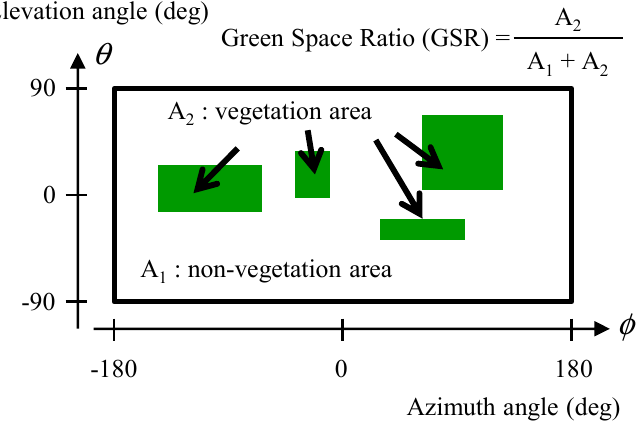
Figure 3. Occlusion map for calculating green space ratio (GSR) in azimuth–elevation angle space. GSR is defined as the ratio of occluded vegetation area to the entire area.